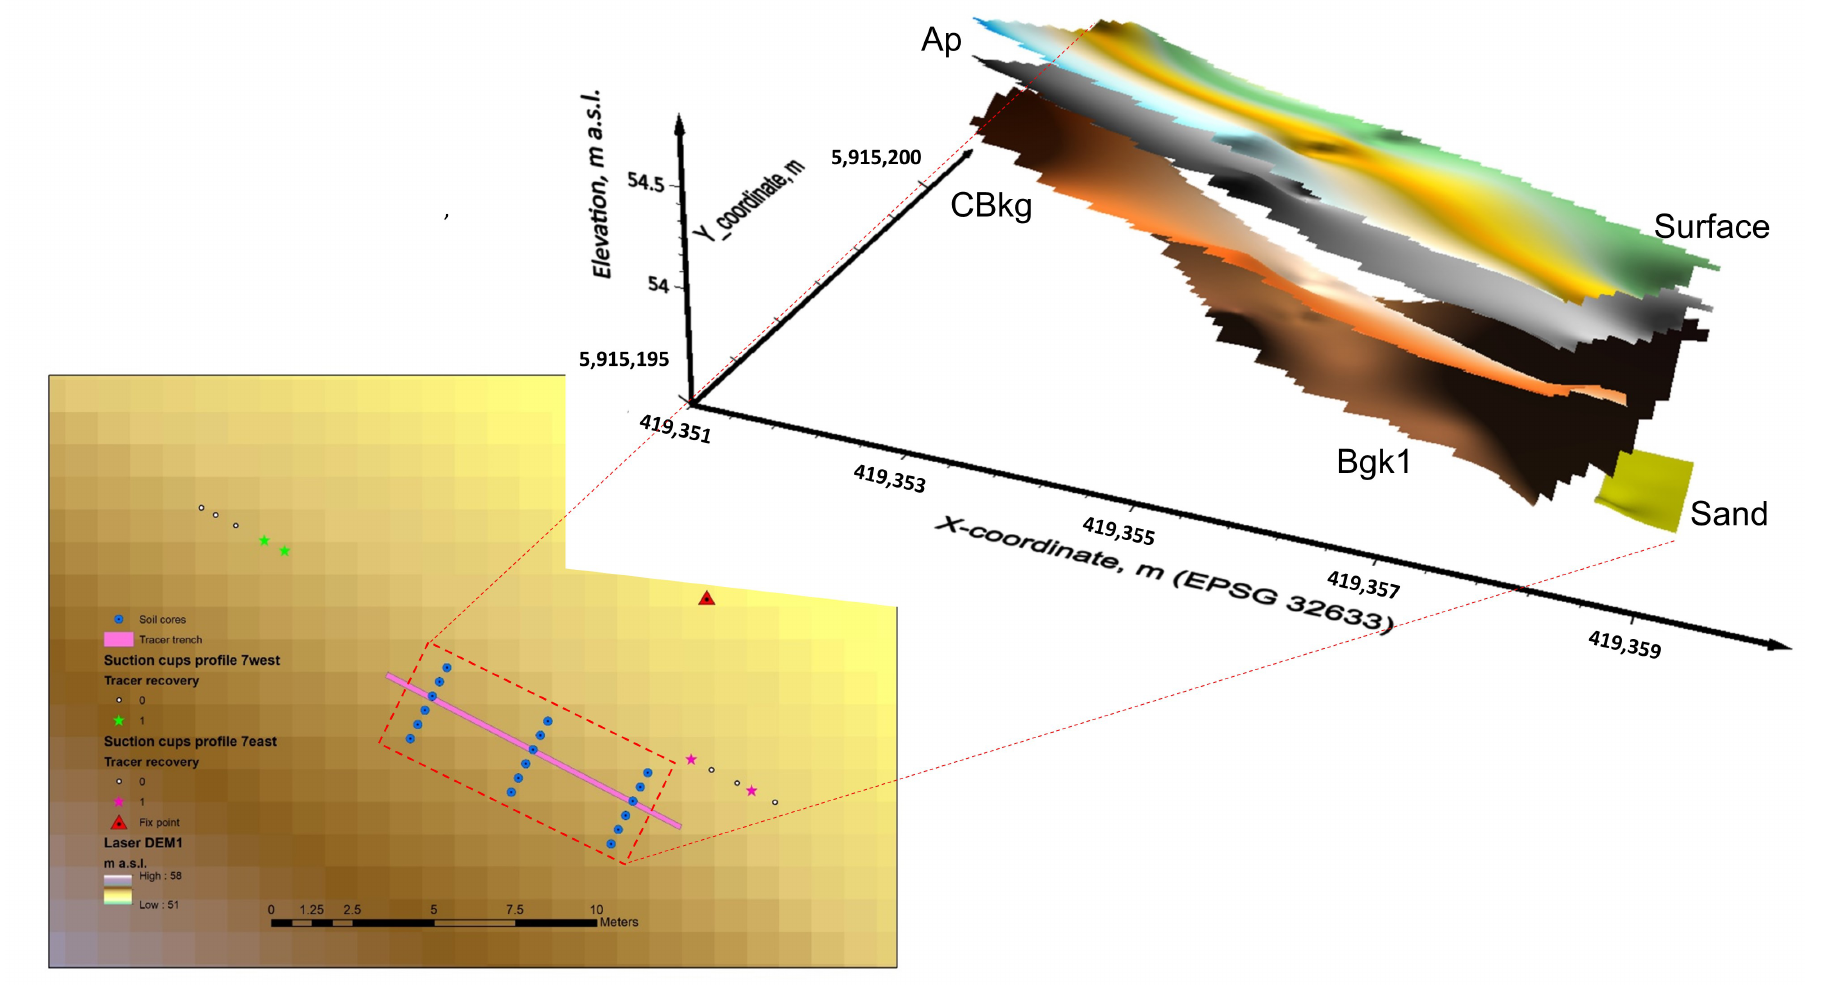
Figure 8. A 3D-reconstruction of the subsurface around the tracer application trench and positions along the suction cup profile, where the Bromide tracer arrived at 160 cm depth. Green and pink stars indicate the suction cup positions where the tracer was